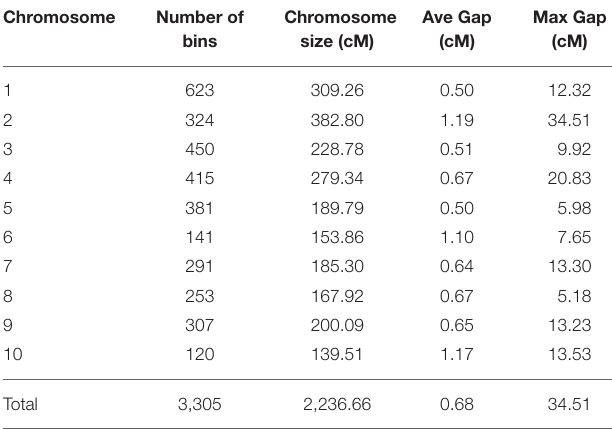
TABLE 1 | Summary statistics of the maize intra-specific genetic linkage map constructed using F 2 individuals derived from the cross of SG5 and